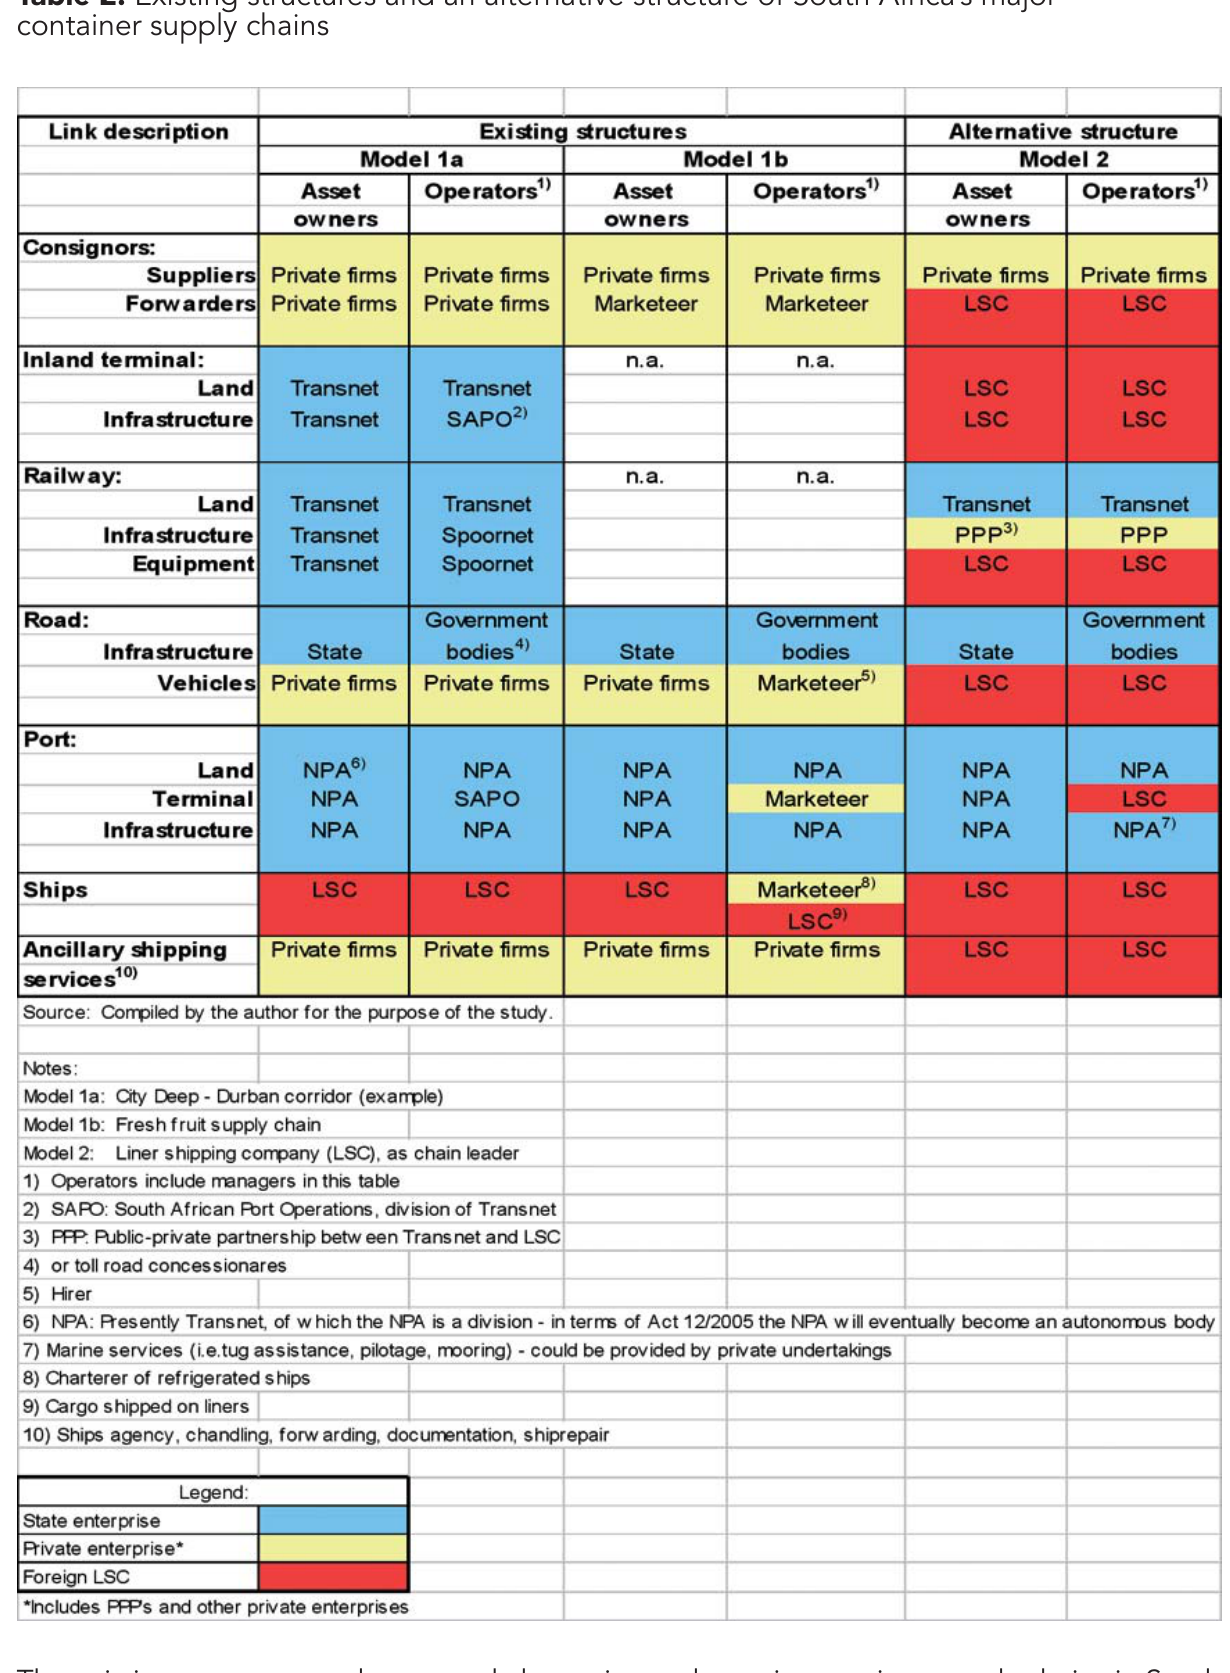
Table 2: Existing structures and an alternative structure of South Africa’s major container supply